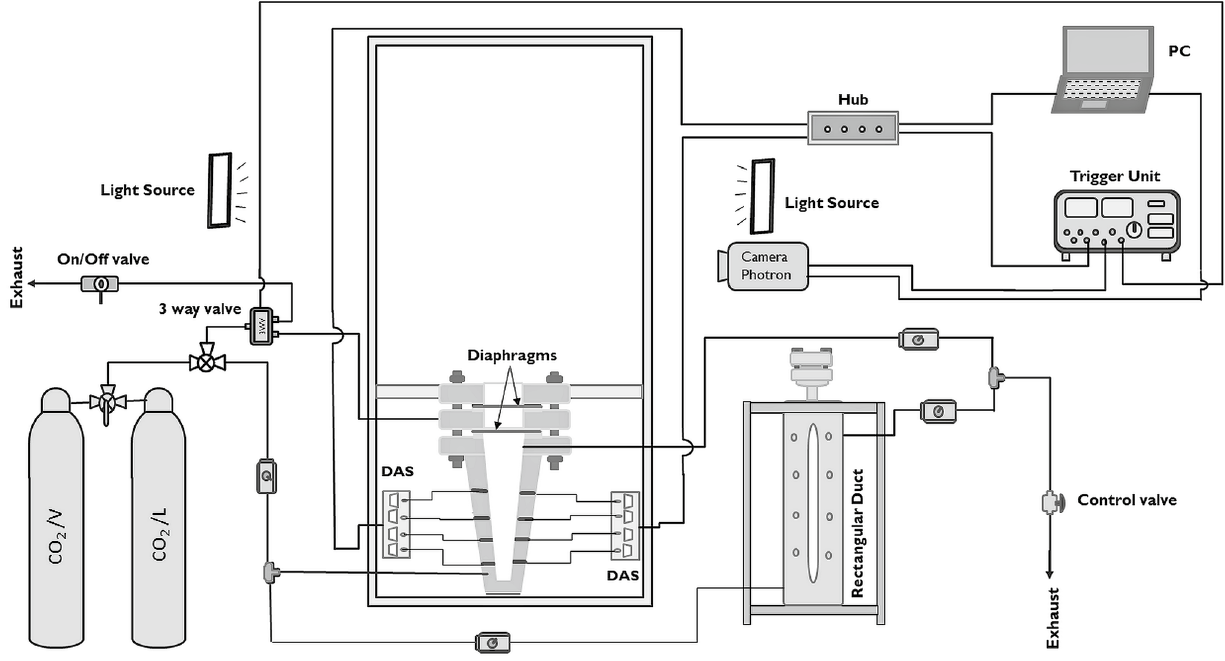
Fig. 4 Graphical illustration of the constituent components of the experimental